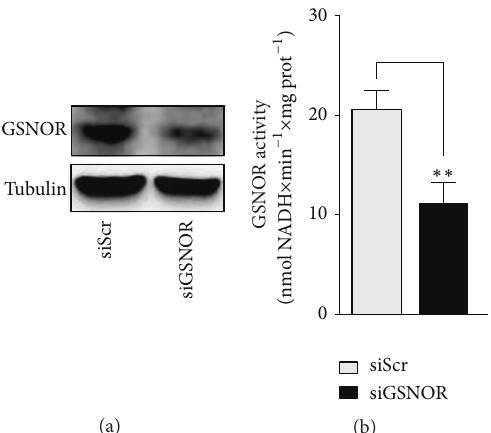
Figure 1: Characterization of siGSNOR cells. (a) Western blotting of GSNOR in total cell lysates of SH-SY5Y cells transiently transfected for 18h with siRNA against GSNOR (siGSNOR) or control scramble siRNA (siScr). (b) Analyses of GSNOR activity in siGSNOR and siScr cells. Western blots shown are representative of at least 𝑛 = 3 independent experiments that gave similar results. Tubulin was selected as loading control. Graphs shown represent the mean of data ± SD of 𝑛 = 3 independent experiments, ∗∗ 𝑃 < 0.01